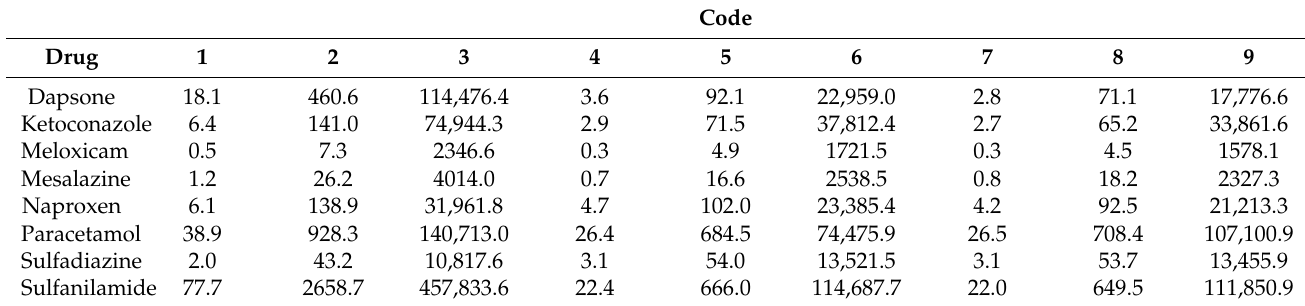
Table 4. E 1 values for different drugs according to numerical analyses codes 1–9.